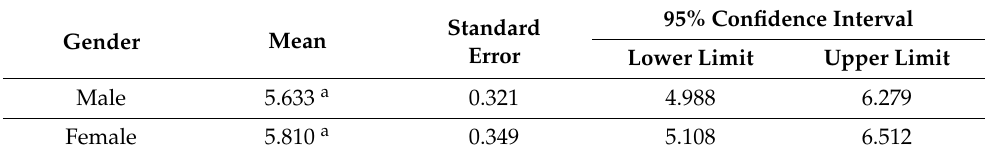
Table 2. Descriptive scores by gender (marginal